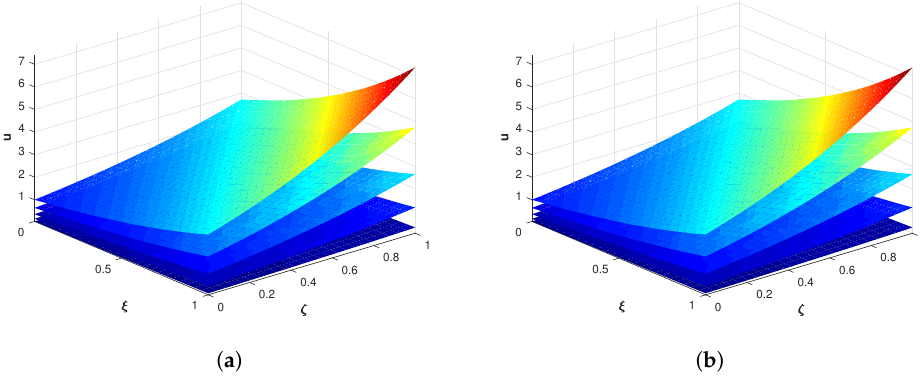
Figure 13. ( a ) Analytic solution of Problem 4 with α = 0.85, N = 625, n = 25, and M = 26. ( b ) Approximate solution of Problem 4 with α = 0.85, N = 625, n = 25, and M = 26. The numerical solution is in good agreement with the exact